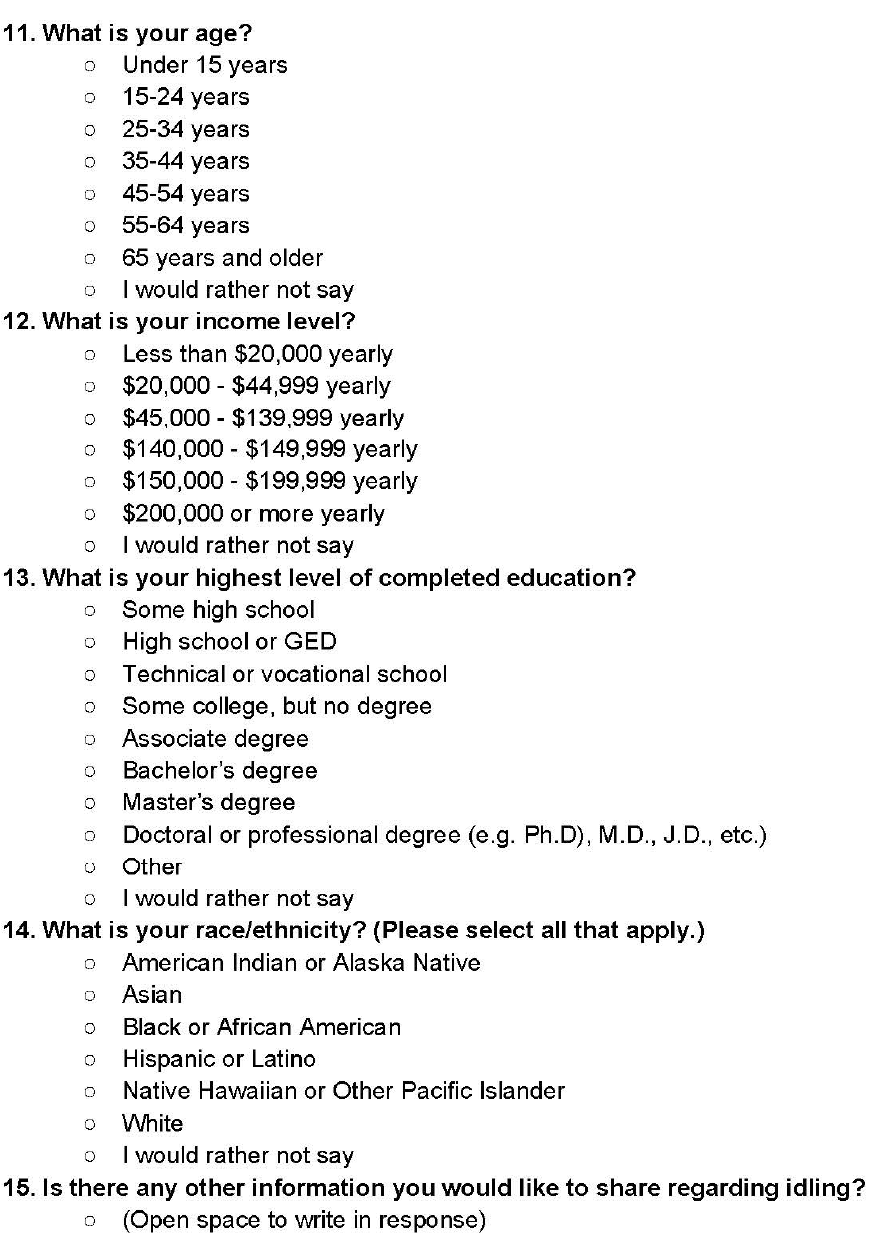
Figure A3. Clean air campaign community survey page 3 of 3.